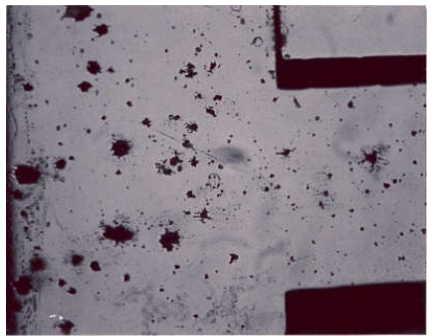
Figure 36. Pitting corrosion in the longitudinal surface of the link (H profile). Optical examination, magnification 5×. Sample #5.